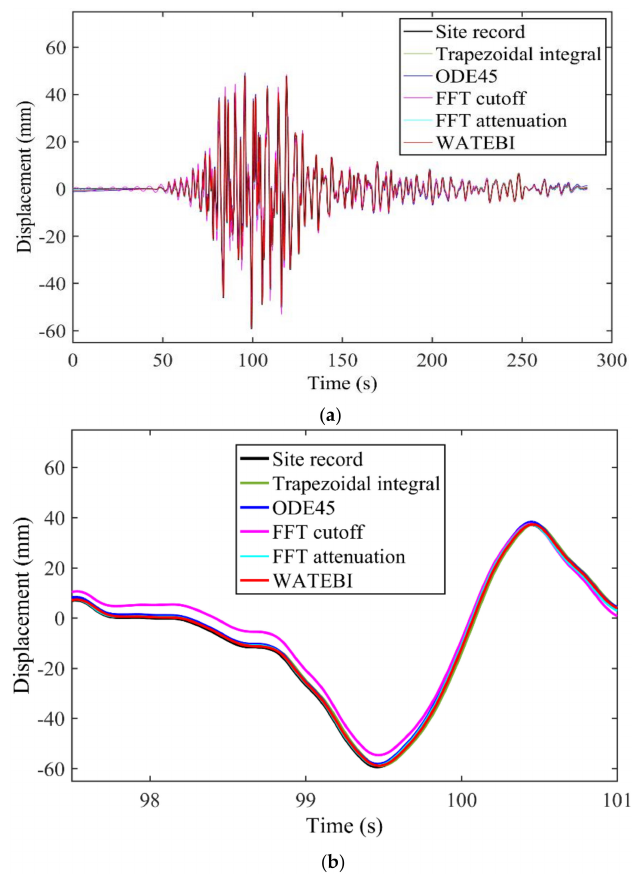
Figure 12. Displacement of Kaikoura ground motion: ( a ) Full duration; ( b ) Enlarged detail at largest trough.